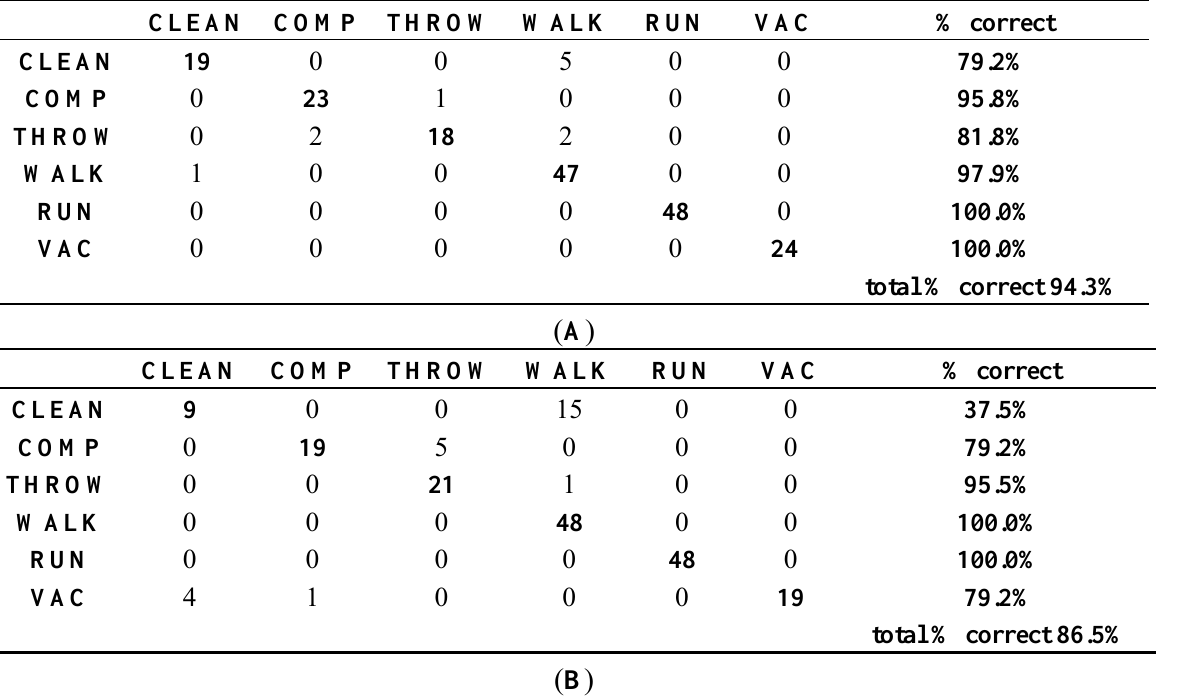
Table 2. Activity type classification accuracy using the TD feature model. ( A ) Trained on GENEA and predicted using GENEA, ( B ) Trained on GENEA and predicted using